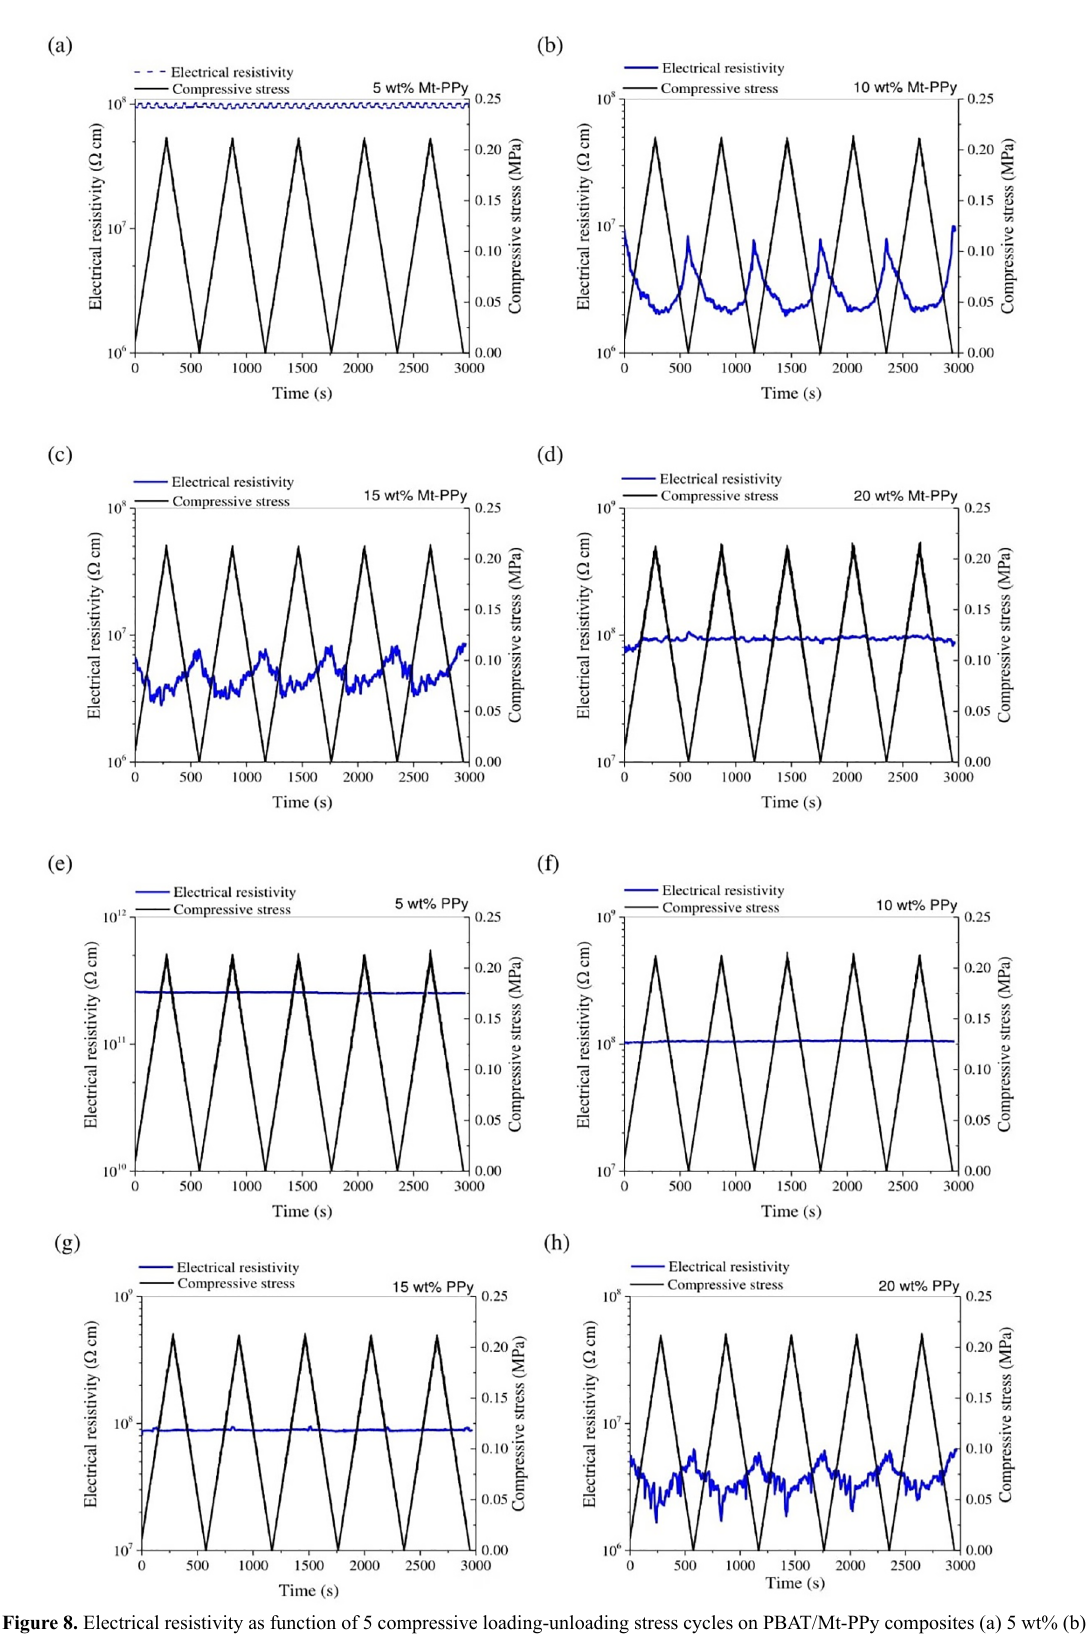
Figure 8. Electrical resistivity as function of 5 compressive loading-unloading stress cycles on PBAT/Mt-PPy composites (a) 5 wt% (b) 10 wt% (c) 15 wt% (d) 20 wt% of Mt-PPy and PBAT/PPy blends (e) 5 wt% (f) 10 wt% (g) 15 wt% (h) 20 wt% of